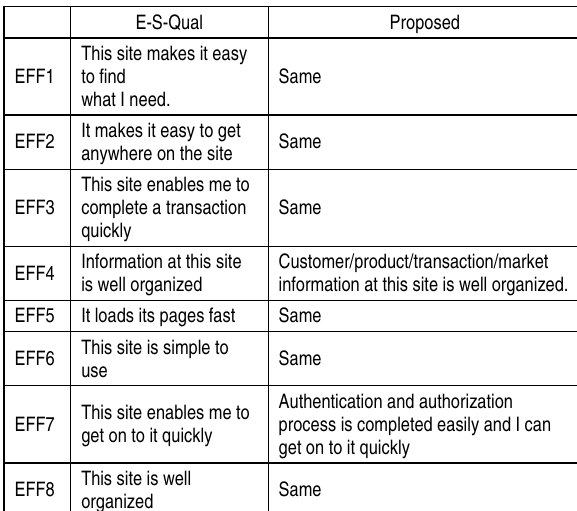
Table 3. Efficiency questions